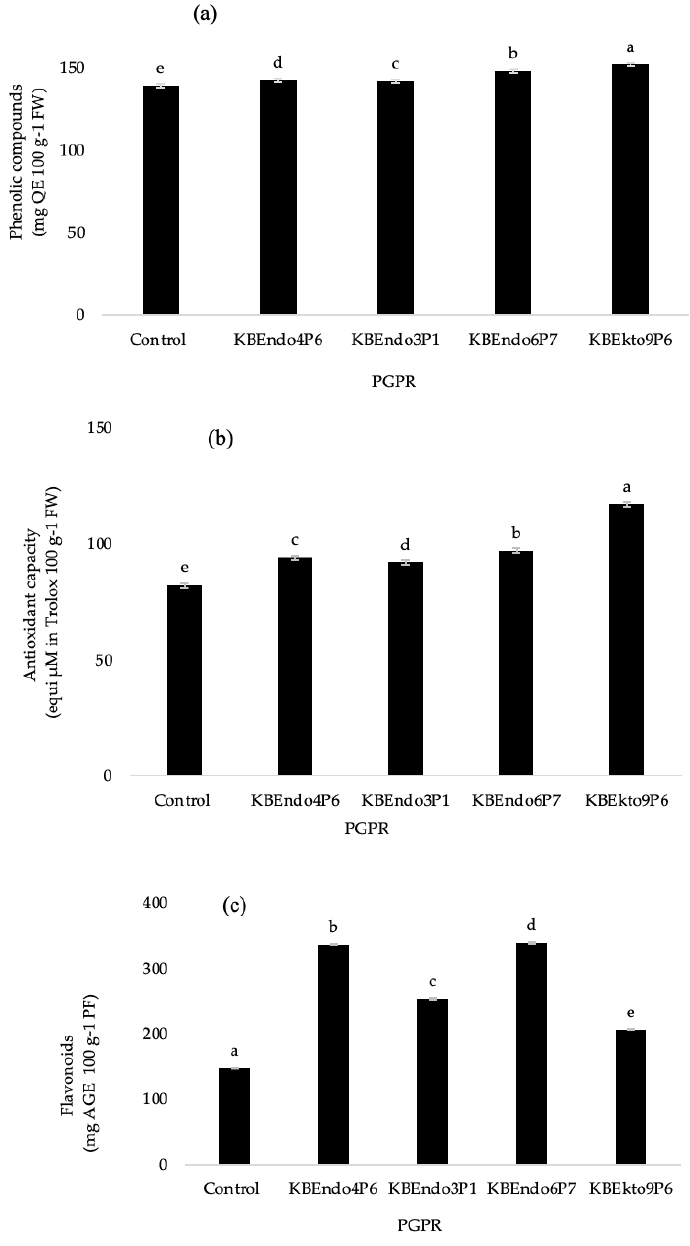
Figure 2. Effect of PGPR on the synthesis of phytochemical compounds. ( a ) Total phenolic com- pounds; ( b ) antioxidant capacity; and ( c ) flavonoids. Data are shown as the mean ± standard deviation (SD, n = 50). The average values in the columns with different letters differ statistically from each other (Tukey’s test p ≤ 0.05).